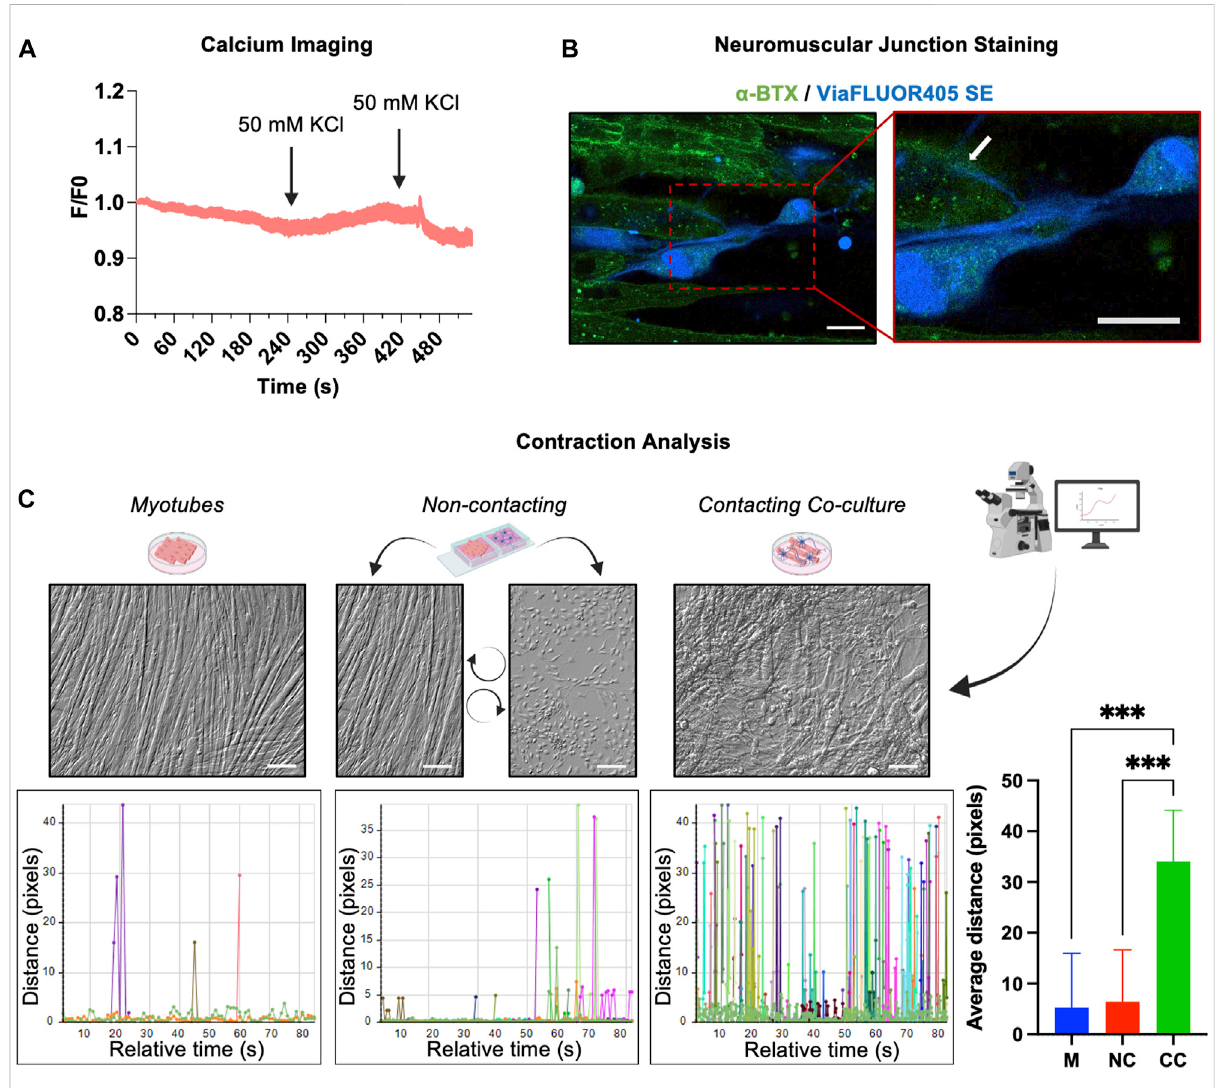
FIGURE 3 Immuno fl uorescent analysis of late MN markers. Immunostaining and the relative fl uorescence intensity for (A) NF-L (green), (B) vAChT (red) and (C) HB9 (green)inundifferentiatedcells (day0)andhAFSC-derivedMNs(day 22).Thenuclei werecounterstainedwith DAPI.Arrows indicatethe cytoskeleton localization of NF-L in (A) , the vesicular staining pattern of vAChT in (B) and the HB9 perinuclear localization in (C) . Original magni fi cation: 40x, scale bar 20 μ m. Red rectangle represents an enlarged area: magni fi cation 60x. Immuno fl uorescence images are representative of 3 independent